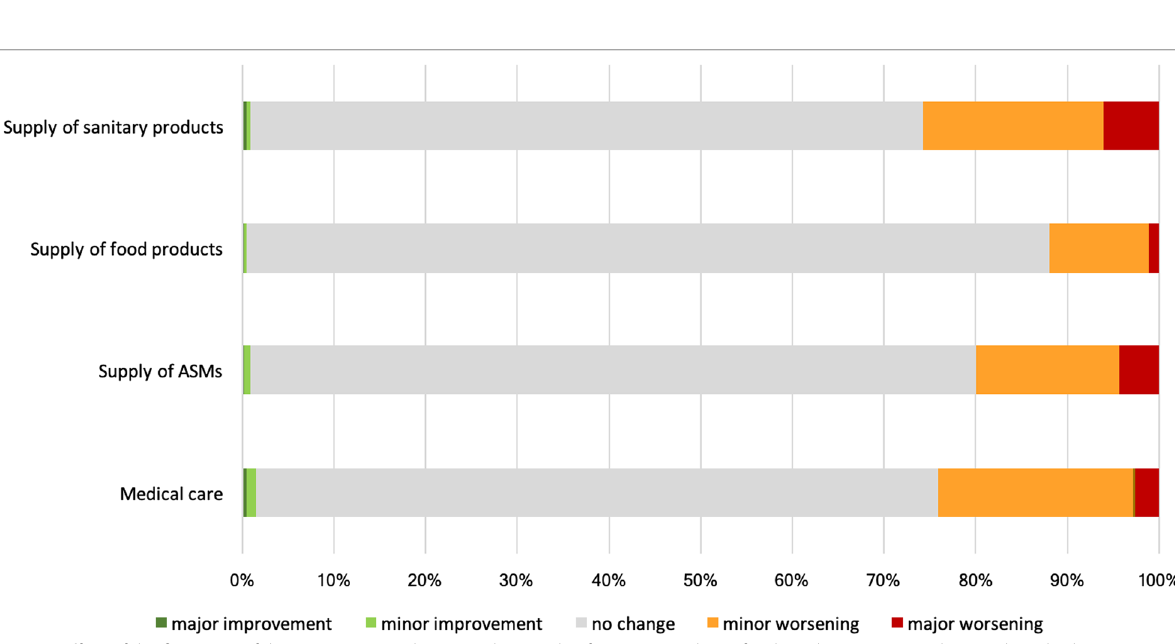
Fig. 3 Effect of the first wave of the COVID‑19 pandemic on the supply of sanitary products, food products, ASMs, and general medical care, as reported on a 5‑point Likert